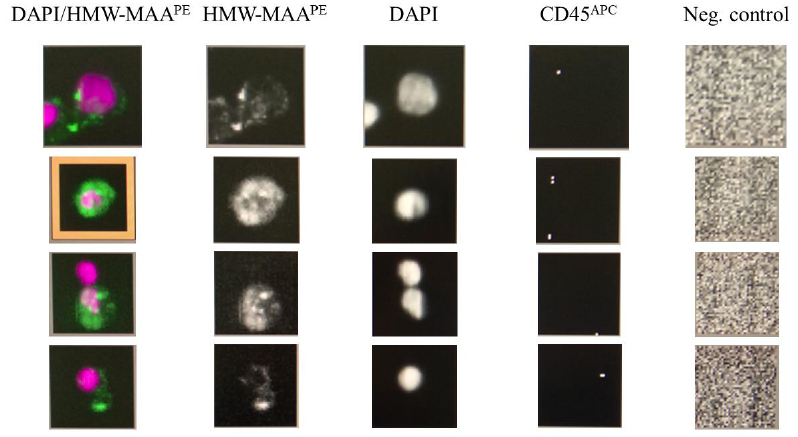
Figure 4. Representative images of CMCs detected in advanced-stage melanoma patients using the CellSearch ® system. Cells were identified as tumor cells according to the following criteria: HMW-MAA-positive, DAPI-positive, CD45-negative, and negative for the last channel.